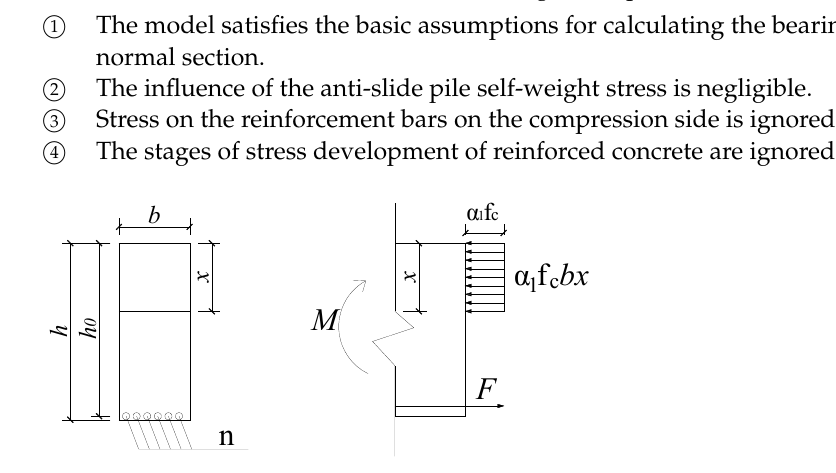
Figure 8. Schematic diagram of single reinforced rectangular normal section bending member model.